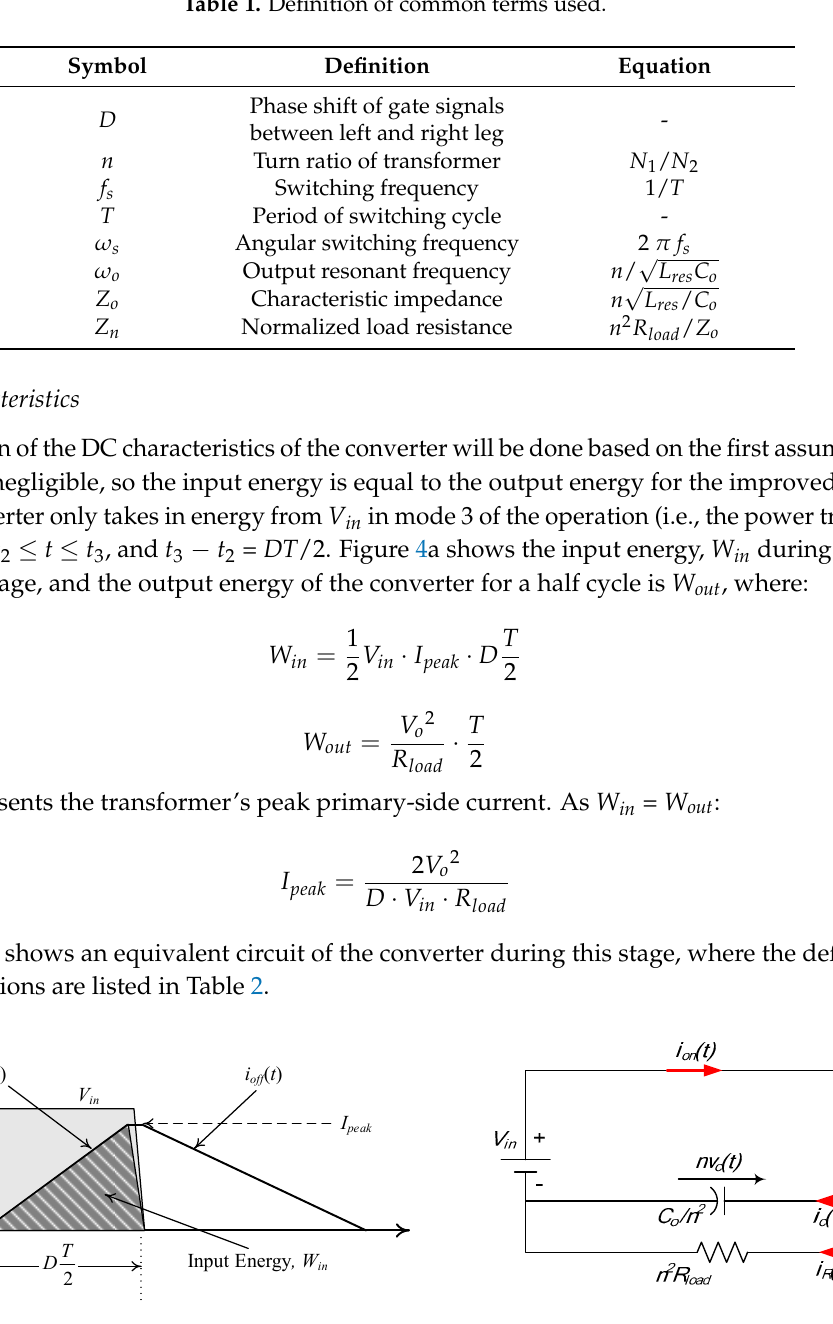
Table 1. Definition of common terms used.